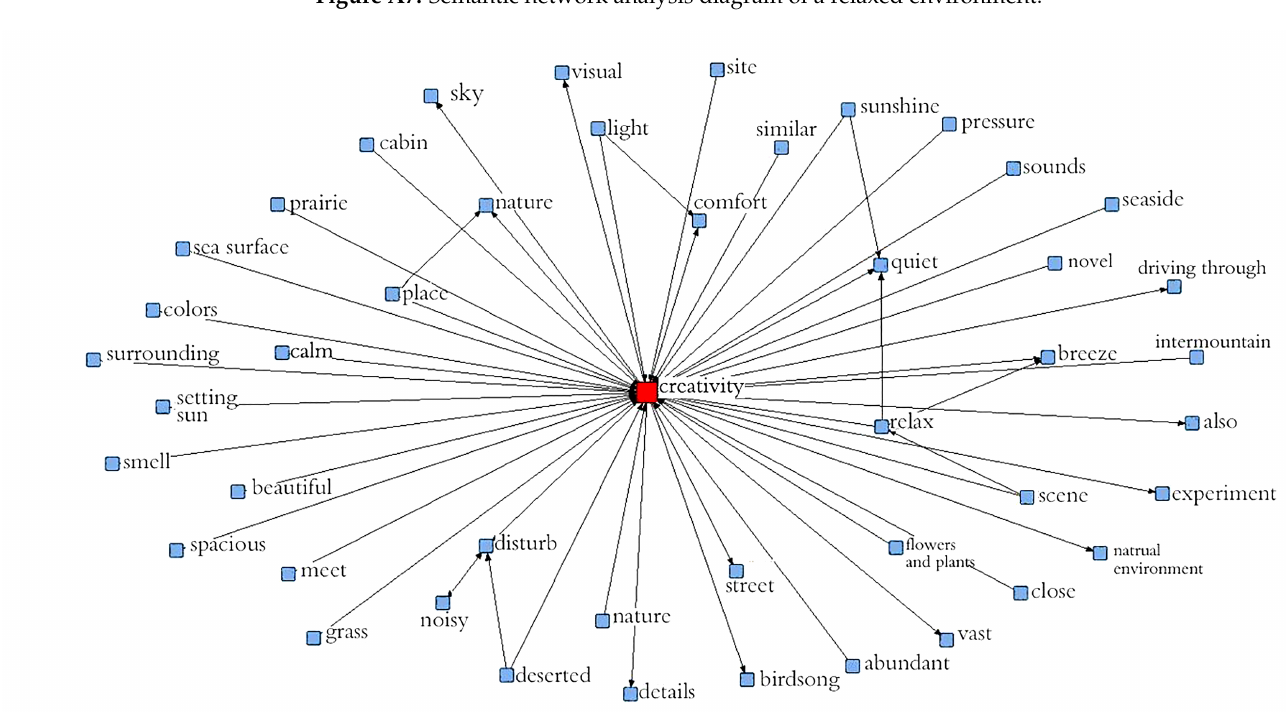
Figure A8. Semantic network analysis diagram of the creative